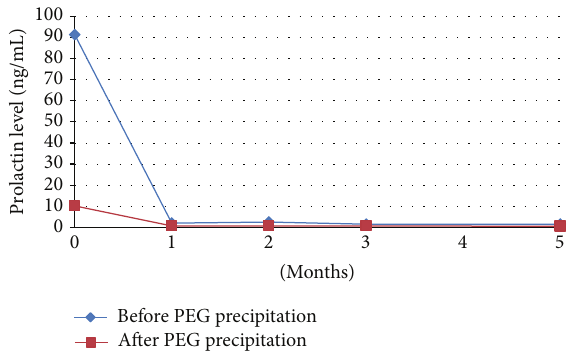
Figure 1: Prolactin levels before and after polyethylene glycol (PEG) precipitation.